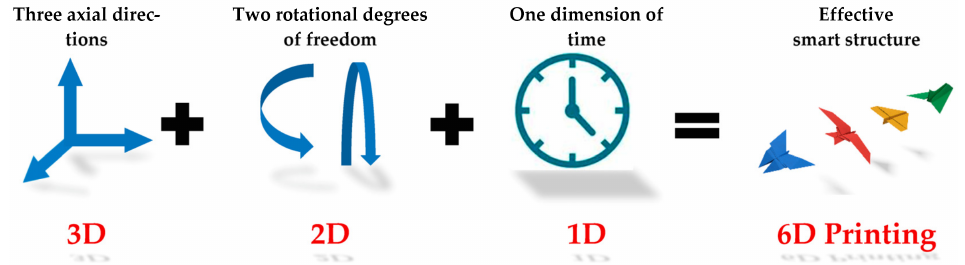
Figure 19. Concept of 6D printing. Reprinted with permission from reference [115], Copyright 2021 by the authors and license MDPI, Basel,